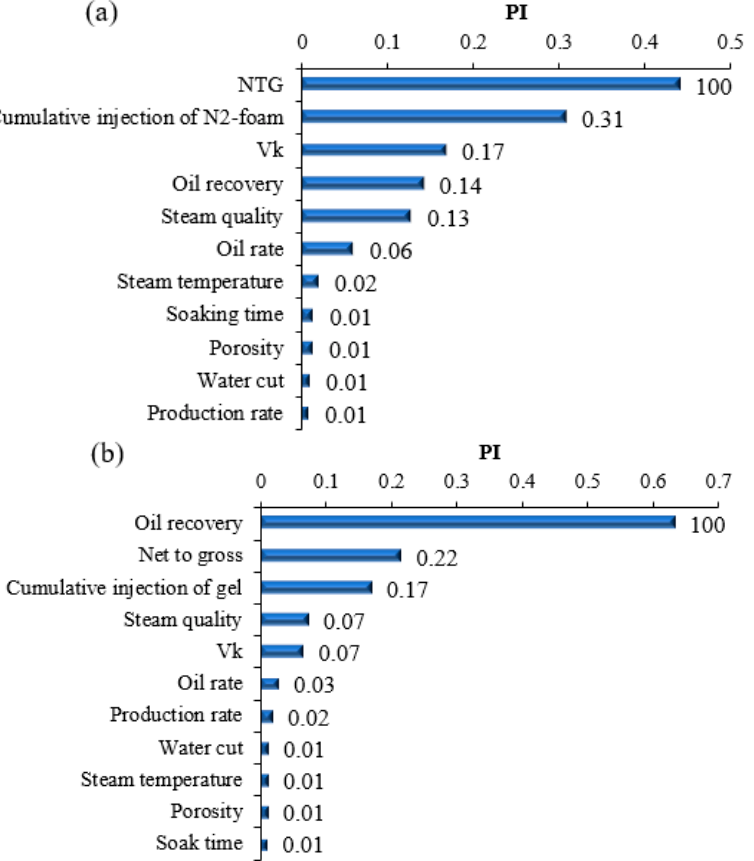
Figure 10. PI values for input variables in ( a ) N2 ‐ foam and ( b ) gel conformance control.